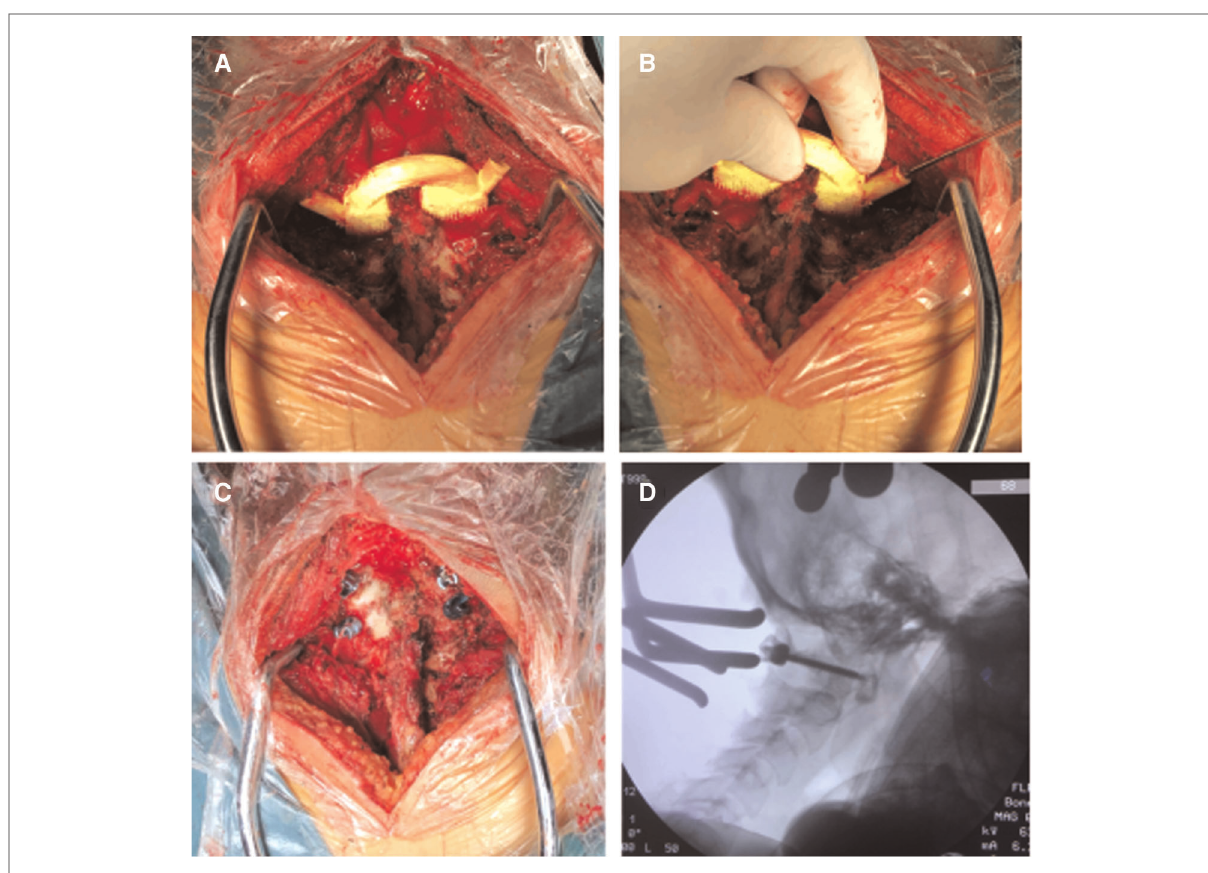
FIGURE 3 Operation process: ( A ) the matching degree of the guide plate was tested again before screwing; ( B ) the corresponding segment guide template was attached after exposure of atlantoaxial vertebrae; ( C ) the hole was drilled with Kirschner wire under the protective sleeve, and tap after the four walls are complete; ( D ) intraoperative fl uoroscopy was used to verify the accuracy of screw